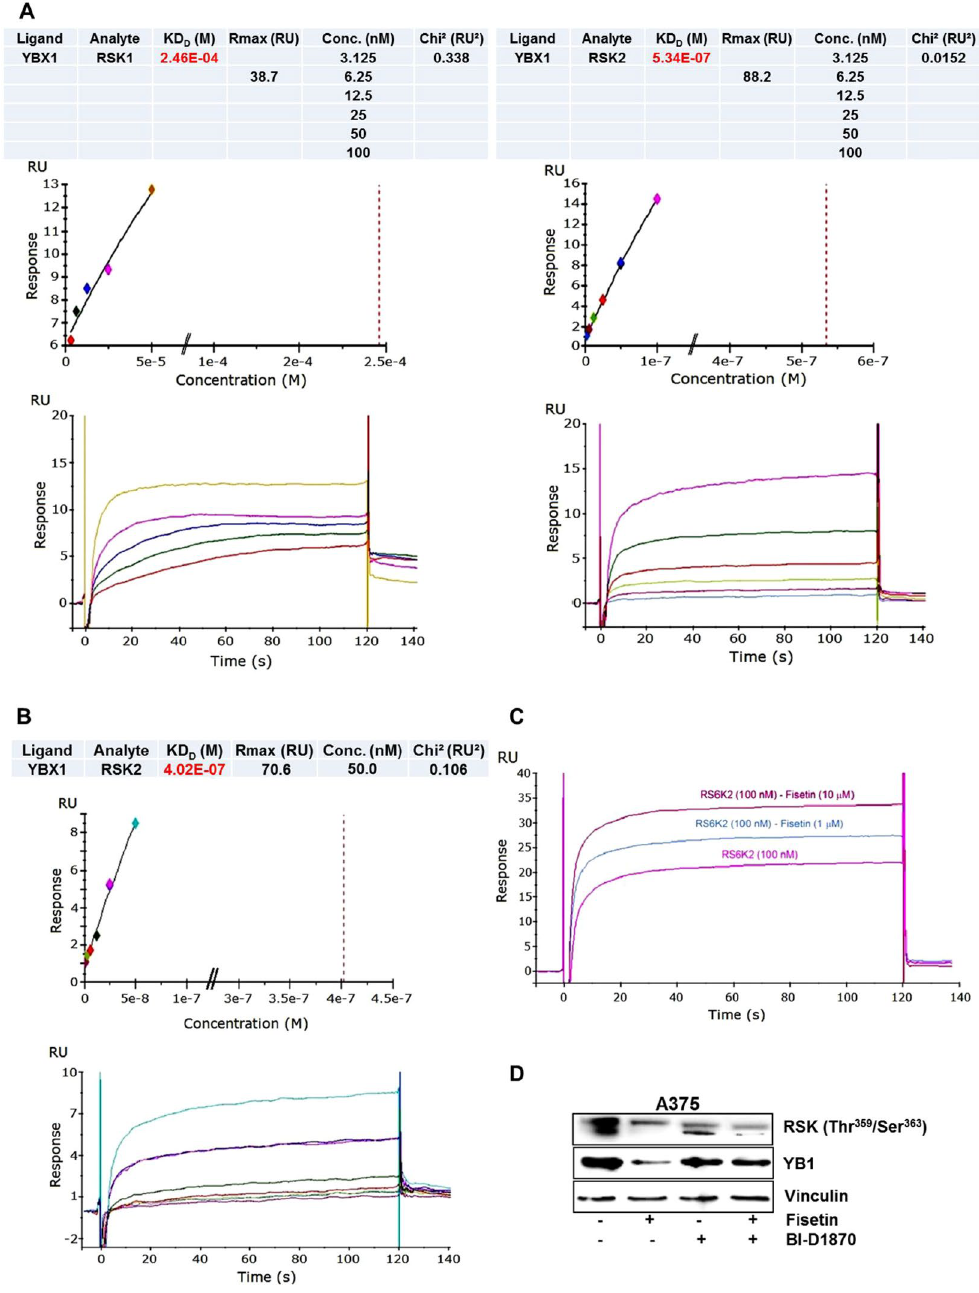
Figure 3. Fisetin/RSK2 complex augments its binding to YB-1 ( A ) Representative SPR sensorgrams showing full kinetics for direct binding characteristics between YB-1 and RSK1 (left) or YB-1 and RSK2 (right). Briefly, YB-1 was directly immobilized on the sensor chip by amine coupling and RSK1 or RSK2 was flown over the protein- coated chip at different concentrations (100-0 nM). ka and kd or steady state kinetics were used for determining the K D . Chi square ( χ 2 ) analysis was carried out between the actual sensorgram (colored line, bottom) and the sensorgram generated from the BIAnalysis software (black line, top) to determine the accuracy of the analysis. χ 2 value within 1–2 was considered significant (accurate), and below 1 was highly significant (highly accurate). ( B ) Representative sensorgram showing full kinetics between YB-1 and RSK2. In the presence of BSA, YB-1 was directly immobilized on the sensor chip by amine coupling and RSK2 was flown over the protein-coated chip at different concentrations (50-0 nM). ( C ) Representative sensorgram for competition assays, where fisetin and RSK2 were flown over immobilized YB-1. The concentration of RSK2 was kept constant (100 nM), but pre- incubated with increasing amounts of fisetin (1 and 10 µ M) and then injected to determine the effect of fisetin on binding activity of the RSK2 to YB-1. Data for affinity evaluation were obtained from a concentration dependent binding curve for the interaction of increasing amounts of fisetin with constant concentration of RSK2. ( D ) Whole cell lysates of fisetin-treated A375 melanoma cells (60 μ M:24 h) with/without RSK inhibitor BI-D1870 were analyzed for YB-1 expression. Equal loading was confirmed by reprobing for